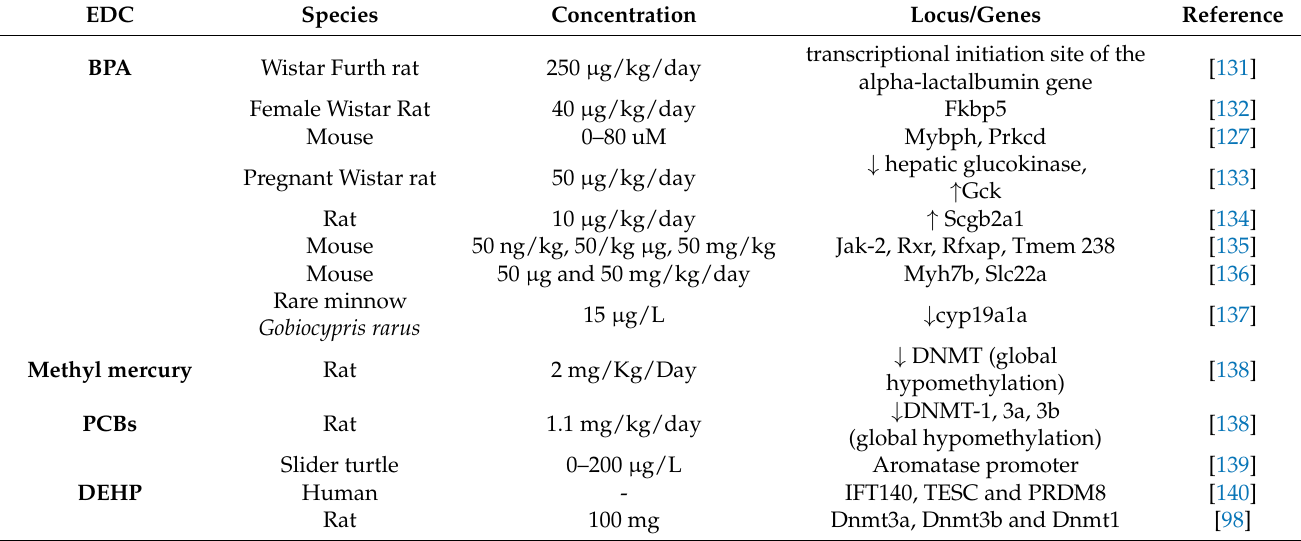
Table 2. Differential DNA methylation caused by different classes of endocrine disrupting chemicals (EDCs).